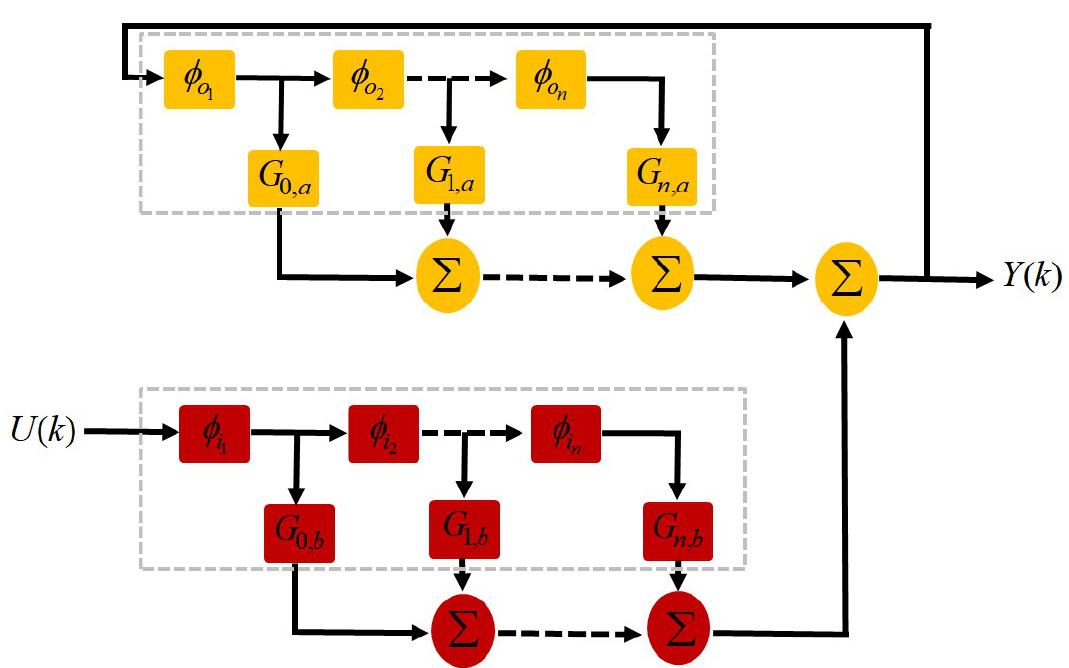
Figure 7. Auto regressive with exogenous input (ARX) Laguerre method for modeling the surgical robot for the sinus manipulator.